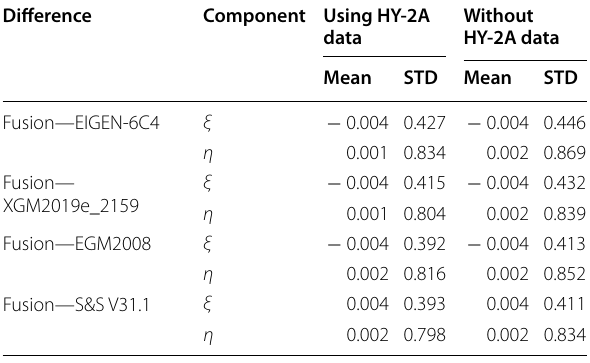
Table 10 Accuracy comparison of deflections of the vertical derived using and not using HY-2A data (unit: arcsec)